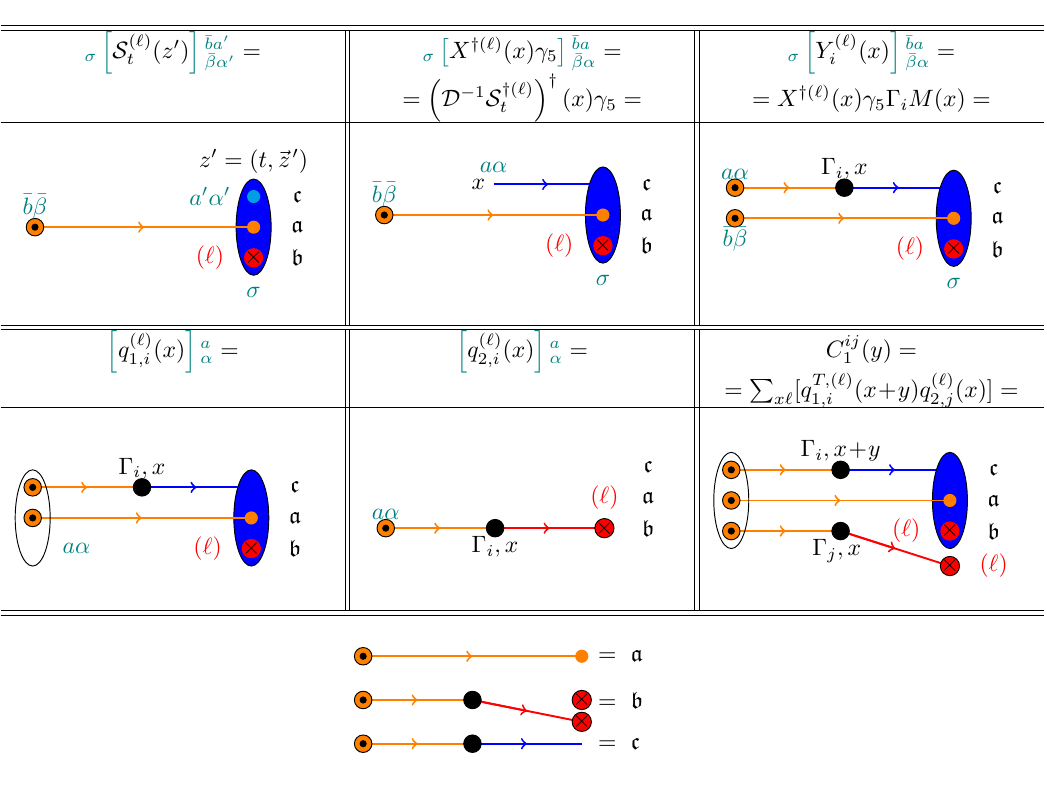
Figure 5 . Detailed illustration of the different parts involved in the evaluation of the C 1 graph. The symbols have the same meaning as in figure 4. For clarity, we also write down the spinor, color and stochastic indices and spacetime arguments. We also indicate the quark lines a , b or c , which are defined at the bottom. Upper panels: left: the sequential source S at timeslice t , which t is a sum of the expressions defined in (A.18). The sequential source already incorporates parts of each quark line. The light blue dot indicates the open spinor and color indices that are used for the inversion of the Dirac operator. Center: sequential propagator X † γ including Hermitian 5 conjugation. Right: the combination of the sequential propagator, the current insertion Γ , and i the forward propagator M , which defines the quantity Y . Lower panels: left: a linear combination of the contractions (A.19), which is called q . This is constructed from the quantity Y . The open 1 baryon spinor index σ of the sink is contracted with the baryon spinor index of the source, which is why it does not appear anymore in q . Center: a part of the stochastic quark line b , which is 1 called q . Right: the complete C graph, which is constructed from q and q (or in some cases 2 1 1 ,i 2 ,j q 1 ,j and q 2 ,i